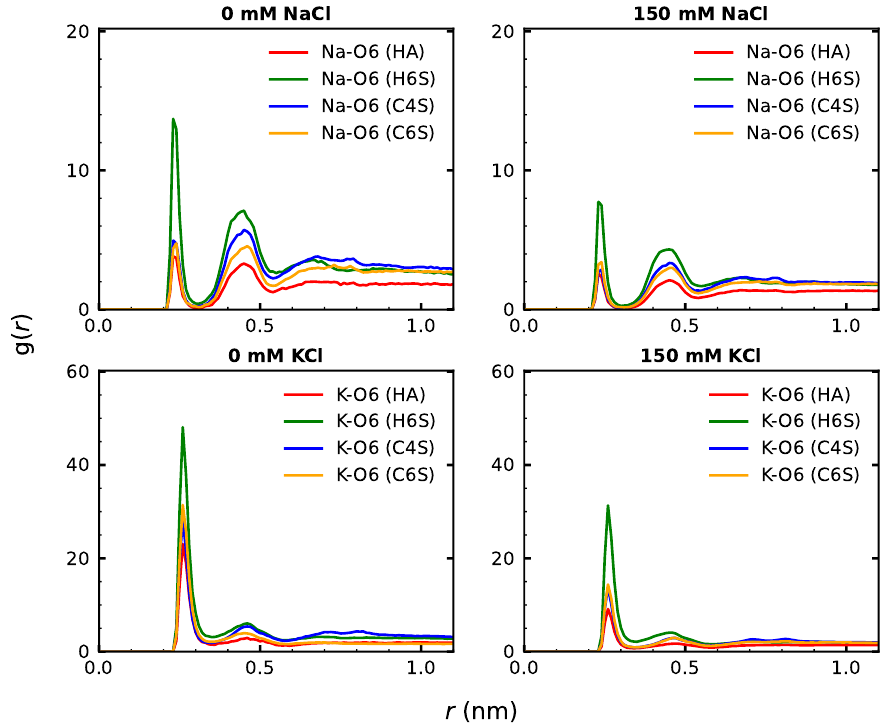
Figure 7. RDF curves representing the interactions between COO − and the cations Na + (top) and K + (bottom) at the 0 mM (left) and 150 mM (right) salt concentration (see the label above each panel). The RDF curves were averaged over both oxygen atoms bound to carbon atom 6 (see Figure S6 for the atom naming) of GlcUA and over the five GlcUA units per GAG, in addition to averaging over the simulation